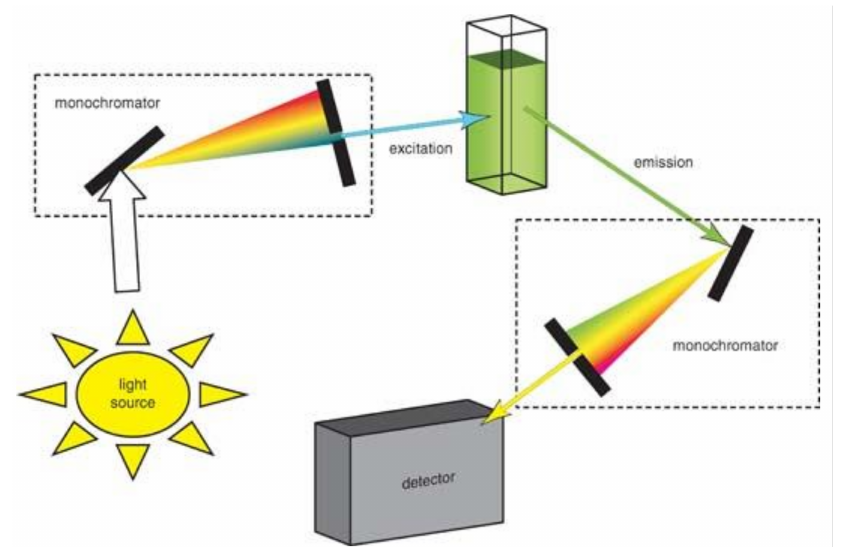
Figure 4. Schematic diagrams of a spectrofluorometer (image taken from https://chem.libretexts.org/ Bookshelves/Analytical_Chemistry/Physical_Methods_in_Chemistry_and_Nano_Science_(Barron) (accessed on 8 November